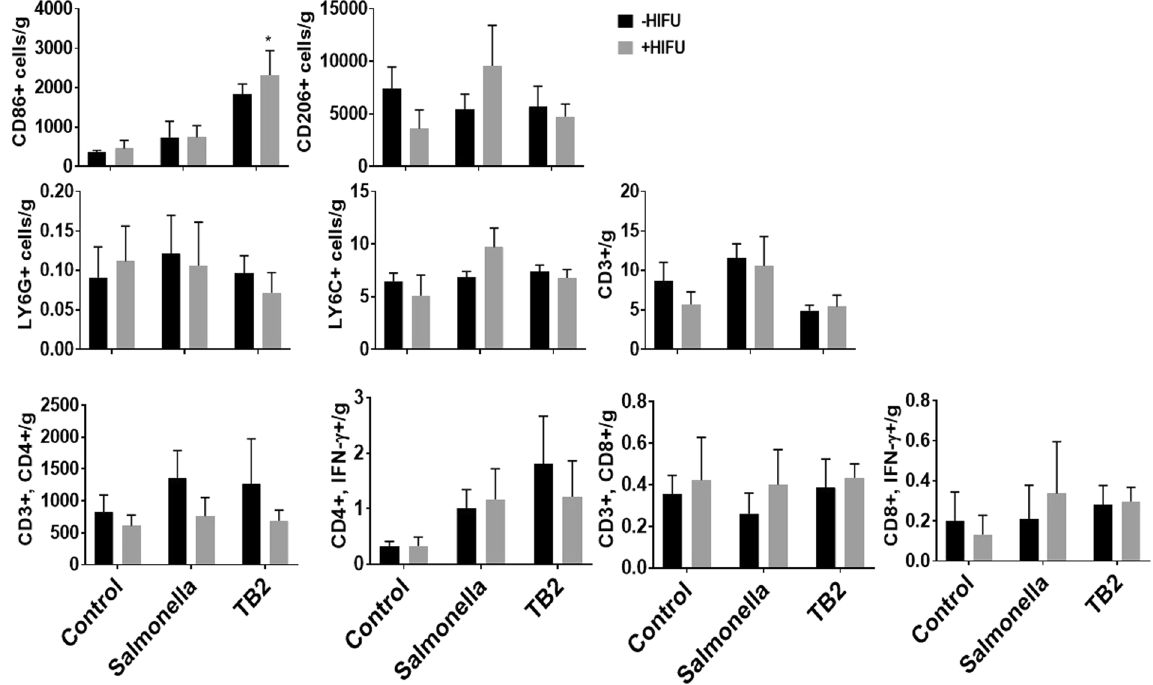
Figure 5. Evaluation of infiltration of immune cells in colon tumors by flow cytometry. Tumor cells were labelled ex-vivo with following panels: macrophages (CD11b + , CD86 + /CD206 + ), MDSC’s (CD11b + , Ly6C + /Ly6G + ) and T cells (CD3 + , CD4 + /CD8 + , IFN- γ+ ). Percentage of M1 infiltrating macrophages was significantly increased in colon tumors following TB and HIFU therapy compared to other groups. Percentage of CD3 + CD4 + IFN- γ T-cell was increased for TB and Salmonella relative to control group, however, the population of CD8 + cells were unaltered. The influx of granulocytic (Ly6G + ) or monocytic (Ly6C + ) myeloid- derived suppressor cells (MDSCs) was not altered by single TB/HIFU treatment. Data (n = 6, means ± SEM) represents percent positive population of immune cells in the tumors ( * p <